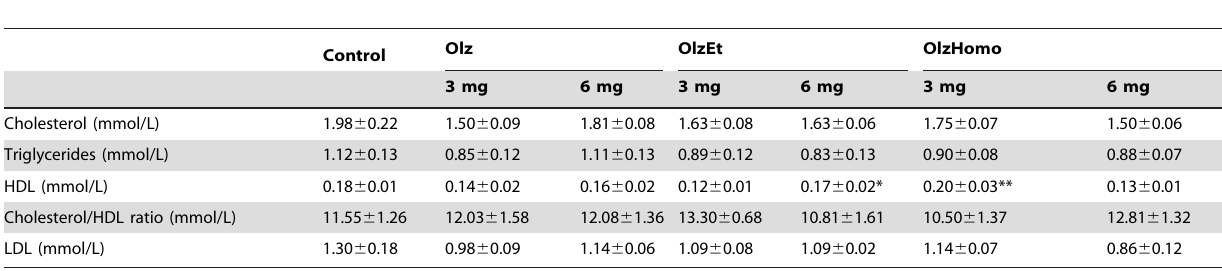
Mean concentrations of plasma lipids and glucose in female Sprague Dawley rats following 5 weeks treatment with Olz, OlzEt, OlzHomo (3 mg/kg or 6 mg/kg), or vehicle (Control). Data are expressed as mean 6 SEM, * P , 0.05, and. ** P , 0.01 vs .